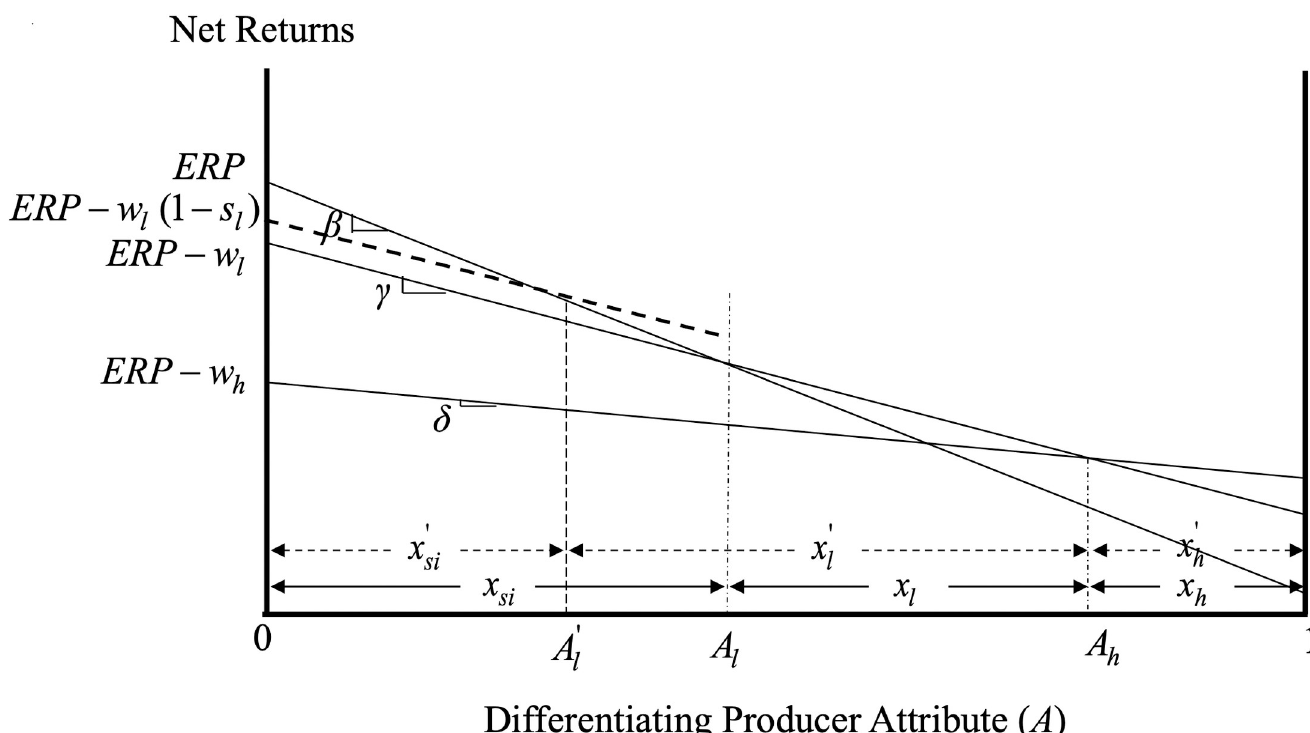
Fig 4. Mechanism that increases participation and maintains a separating equilibrium at reduced